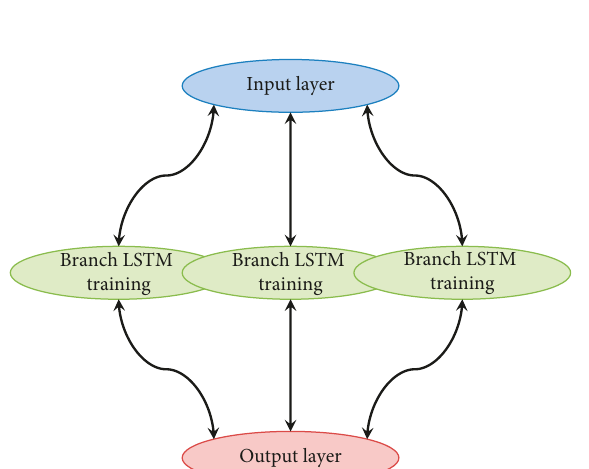
Figure 3: Multibranch LSTM network